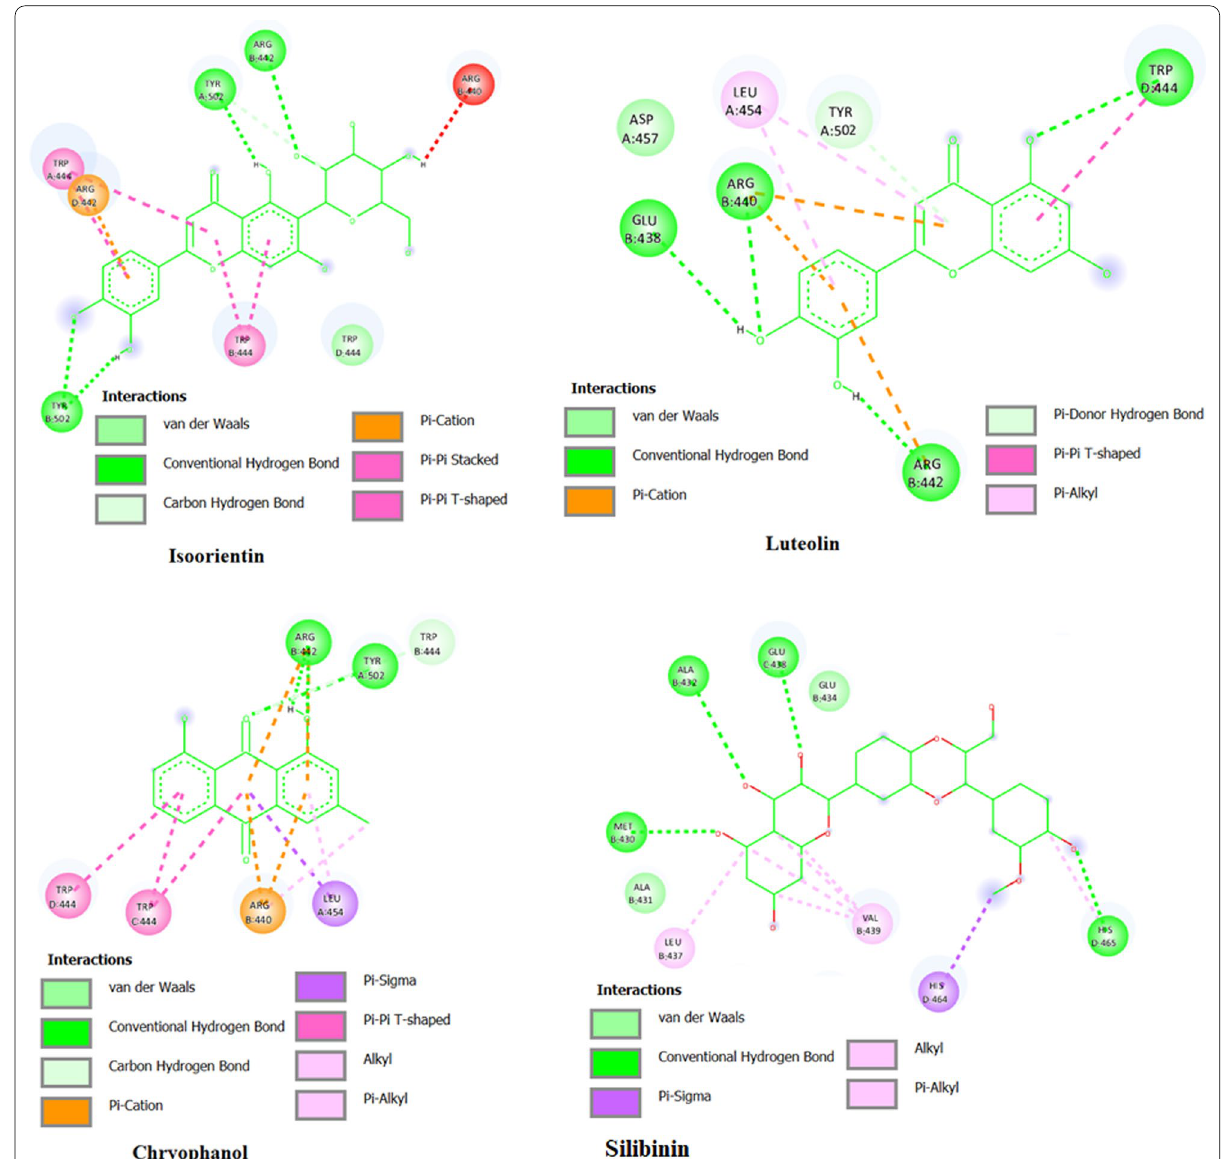
Fig. 6 Binding affinities of Dishevelled protein with phytochemical structure using AutoDock Vina. The 2D structure of protein–ligand interactions is visualized using Discovery studio visualizer and the interactions are predicted based on binding energy (kcal/mol) and hydrogen